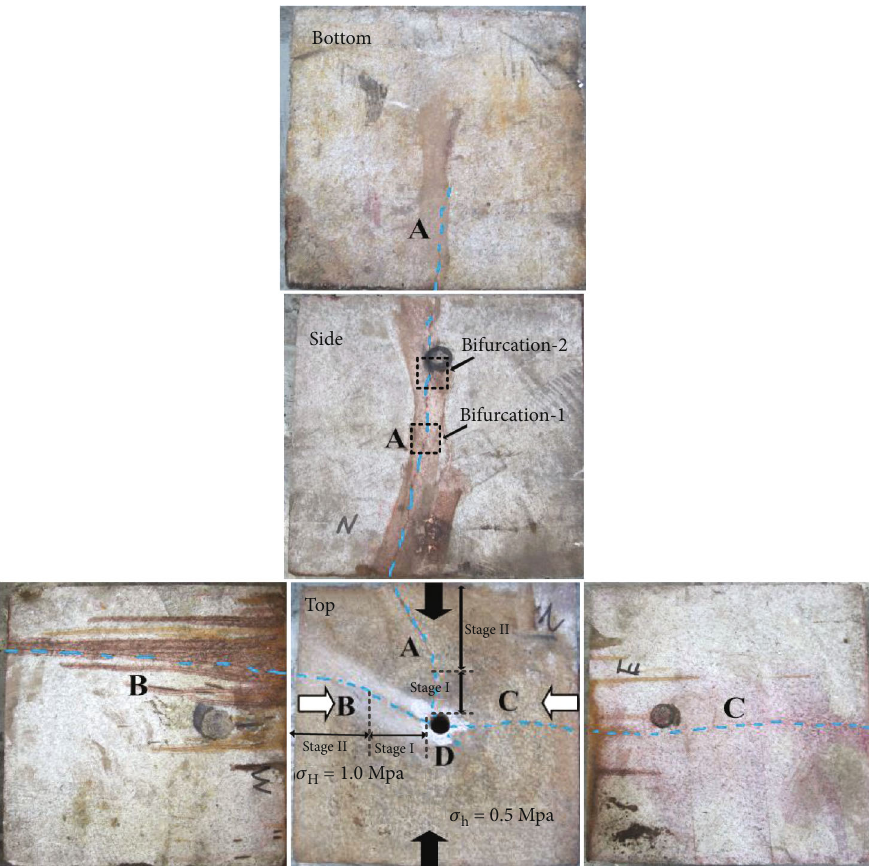
Figure 5: Spatial pattern of the fracture propagation.